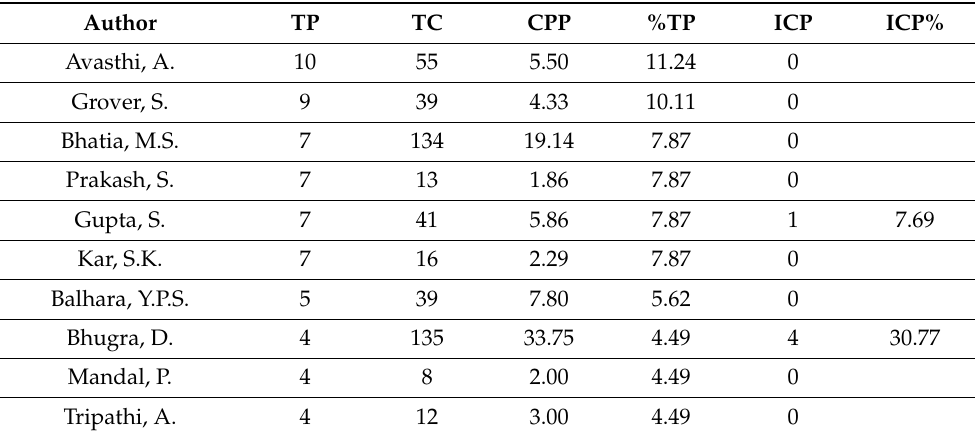
Table 2. The top ten authors on dhat syndrome research (n =